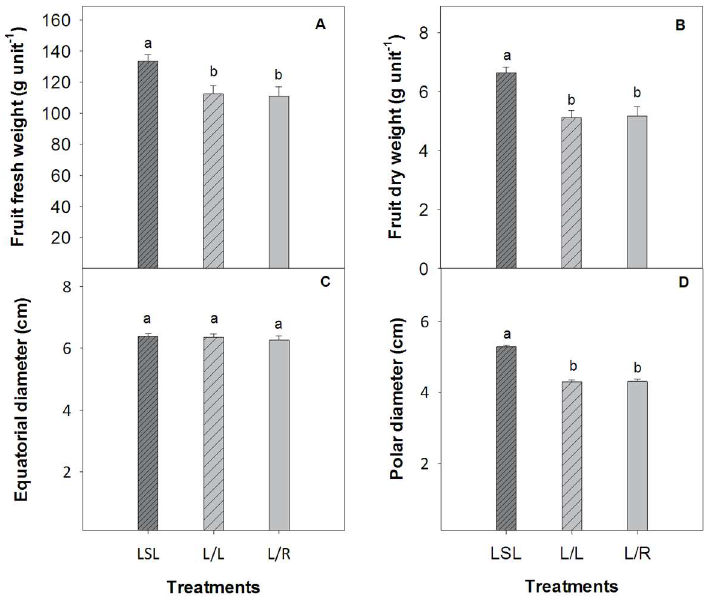
Figure 5. Fruit fresh weight ( A ) (g unit −1 ), fruit dry weight ( B ) (g unit −1 ), equatorial diameter ( C ) (cm) and polar diameter ( D ) (cm) by treatments LSL (long-shelf-life tomato), L/L (self-grafted Old Limachino tomato) and L/R (grafted Old Limachino tomato on Poncho Negro rootstock) under greenhouse conditions. Each value represents the mean ± SE ( n = 12). Lower-case letters indicate differences ( p ≤ 0.05, Duncan test) among treatments.